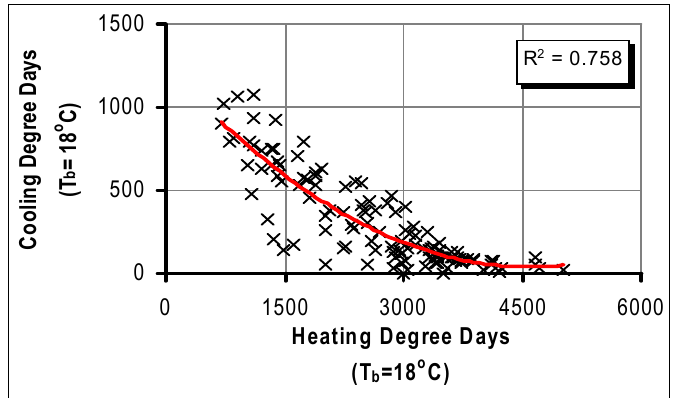
Figure 2. The distribution of Cooling Degree Days at a base temperature 18 °C (CDD18) plotted against Heating Degree Days at a base temperature of 18 °C (HDD18).